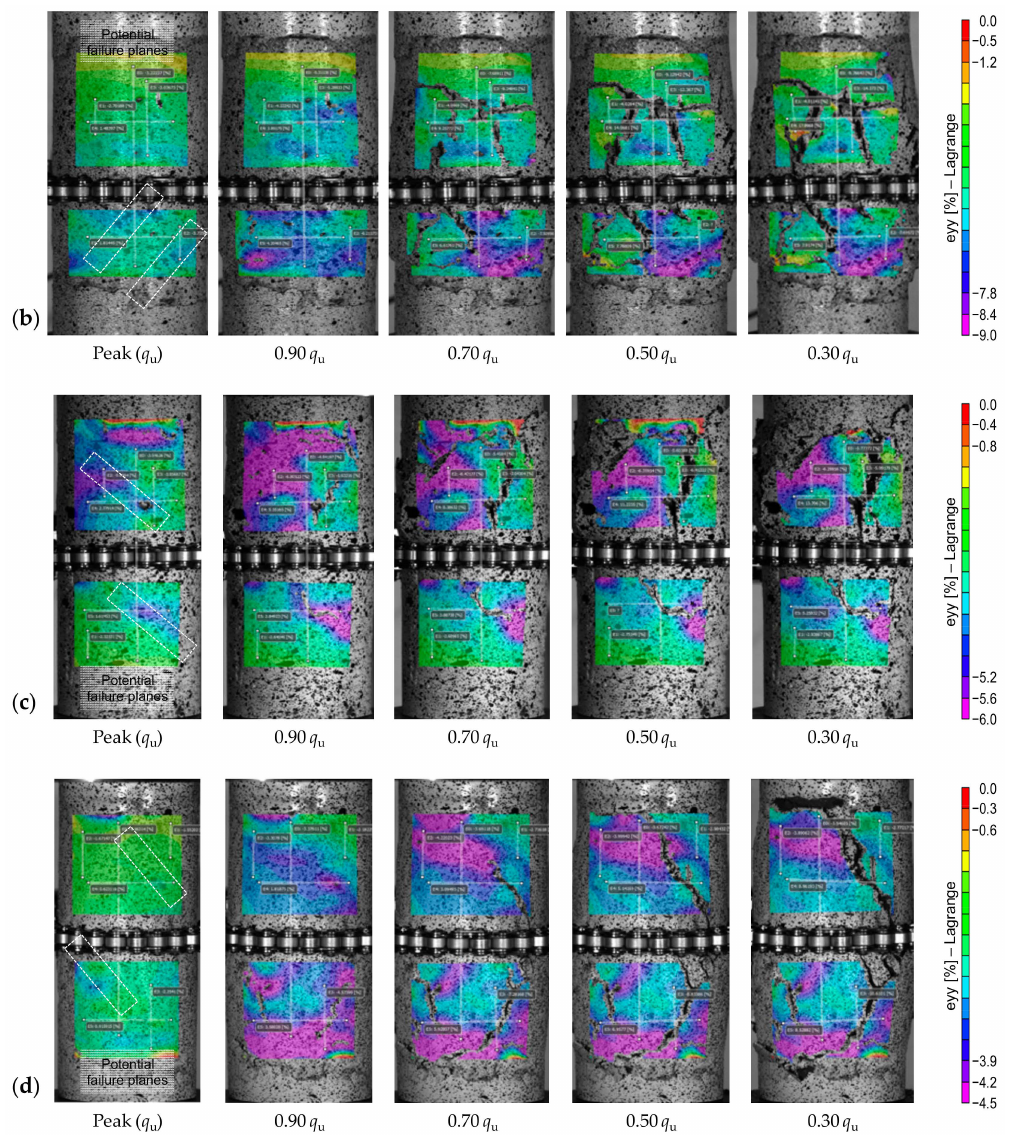
Figure 7. E ff ect of PC content on strain localization—field of axial strains developed at various post-peak axial stress levels: ( a ) P 1 F 0 T 14 ; ( b ) P 2 F 0 T 14 ; ( c ) P 3 F 0 T 14 ; and ( d ) P 5 F 0 T 14